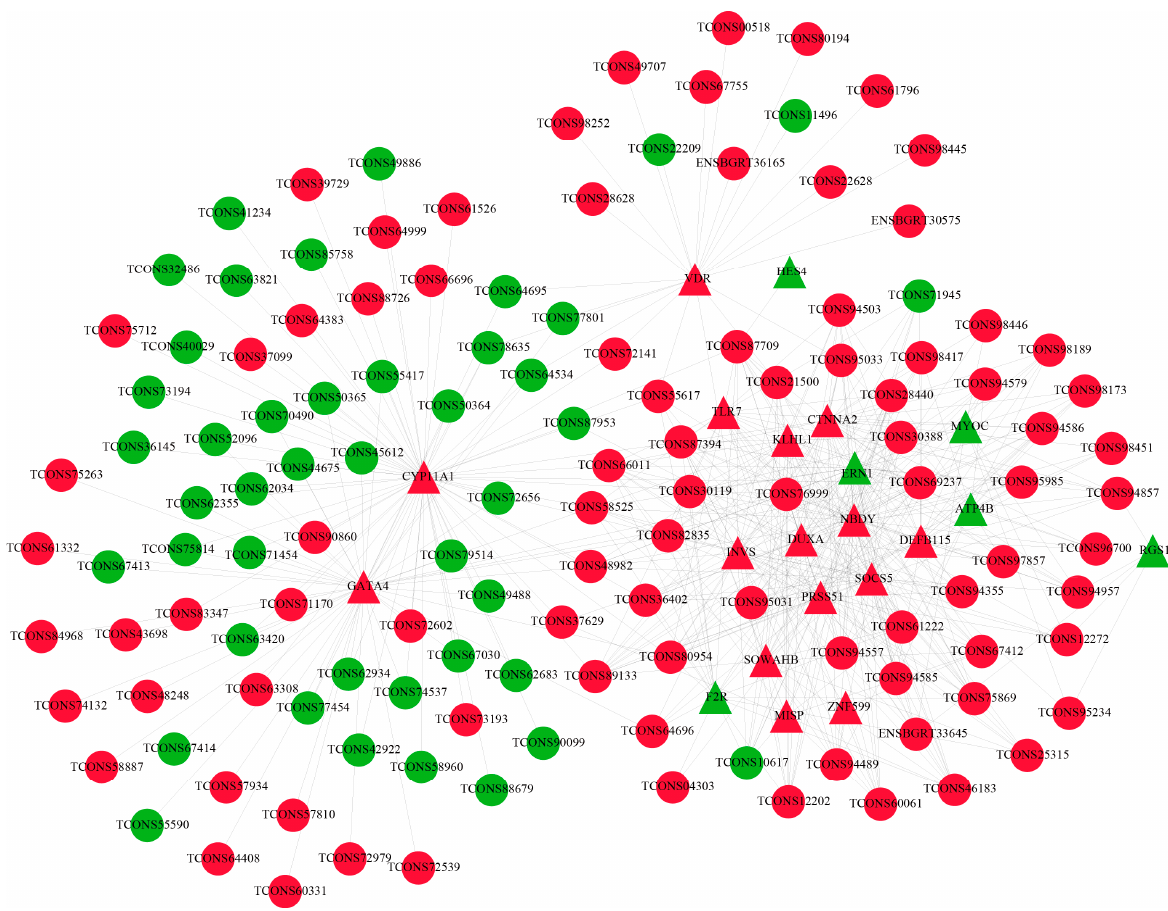
Figure 6. Construction of the lncRNA-mRNA co-expression network. Co-expressed network of common DE lncRNAs and their targeted common DE mRNAs involved in spermatogenesis and cell differentiation processes. Red and green represent upregulated and downregulated, respectively. Ellipses and triangles represent lncRNAs and mRNAs, respectively.